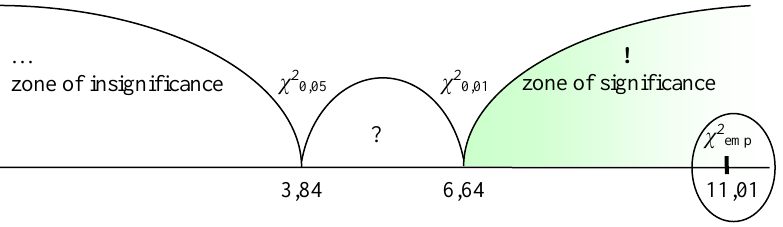
Figure 4: The Pearson’s 𝜒 2 test’s significant axis for the cognitive criterion (after the